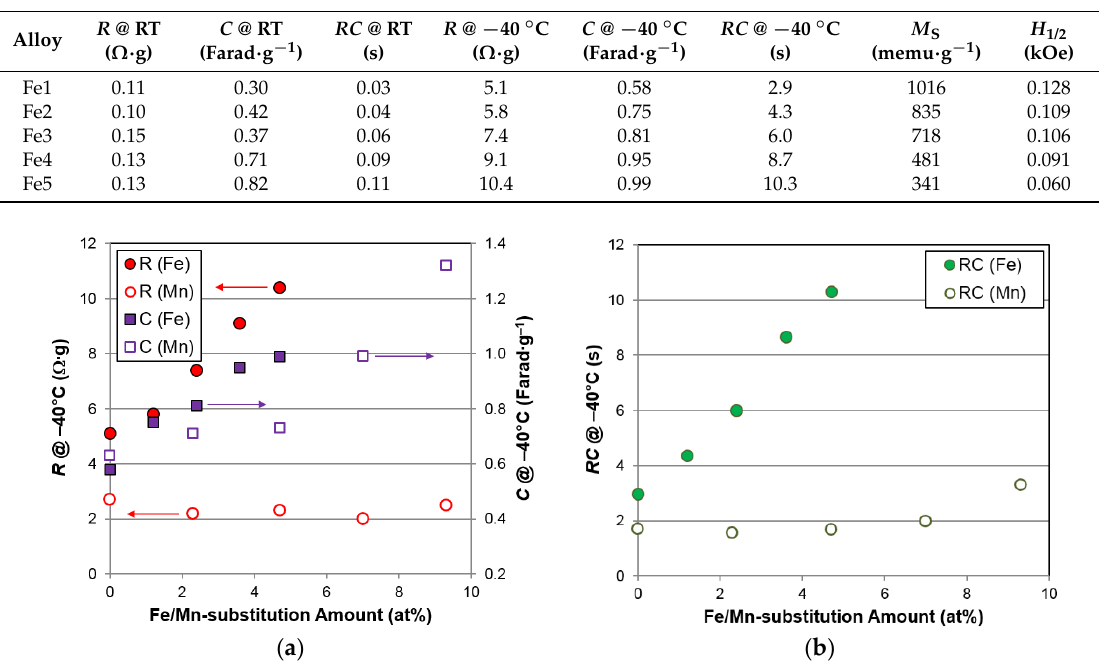
Table 6. Summary of alternative current (AC) impedance and magnetic susceptibility measurement results. R , C , M S , and H 1/2 represent the charge transfer resistance, double-layer capacitance, saturated magnetic susceptibility, and magnetic field at half of M S , respectively.